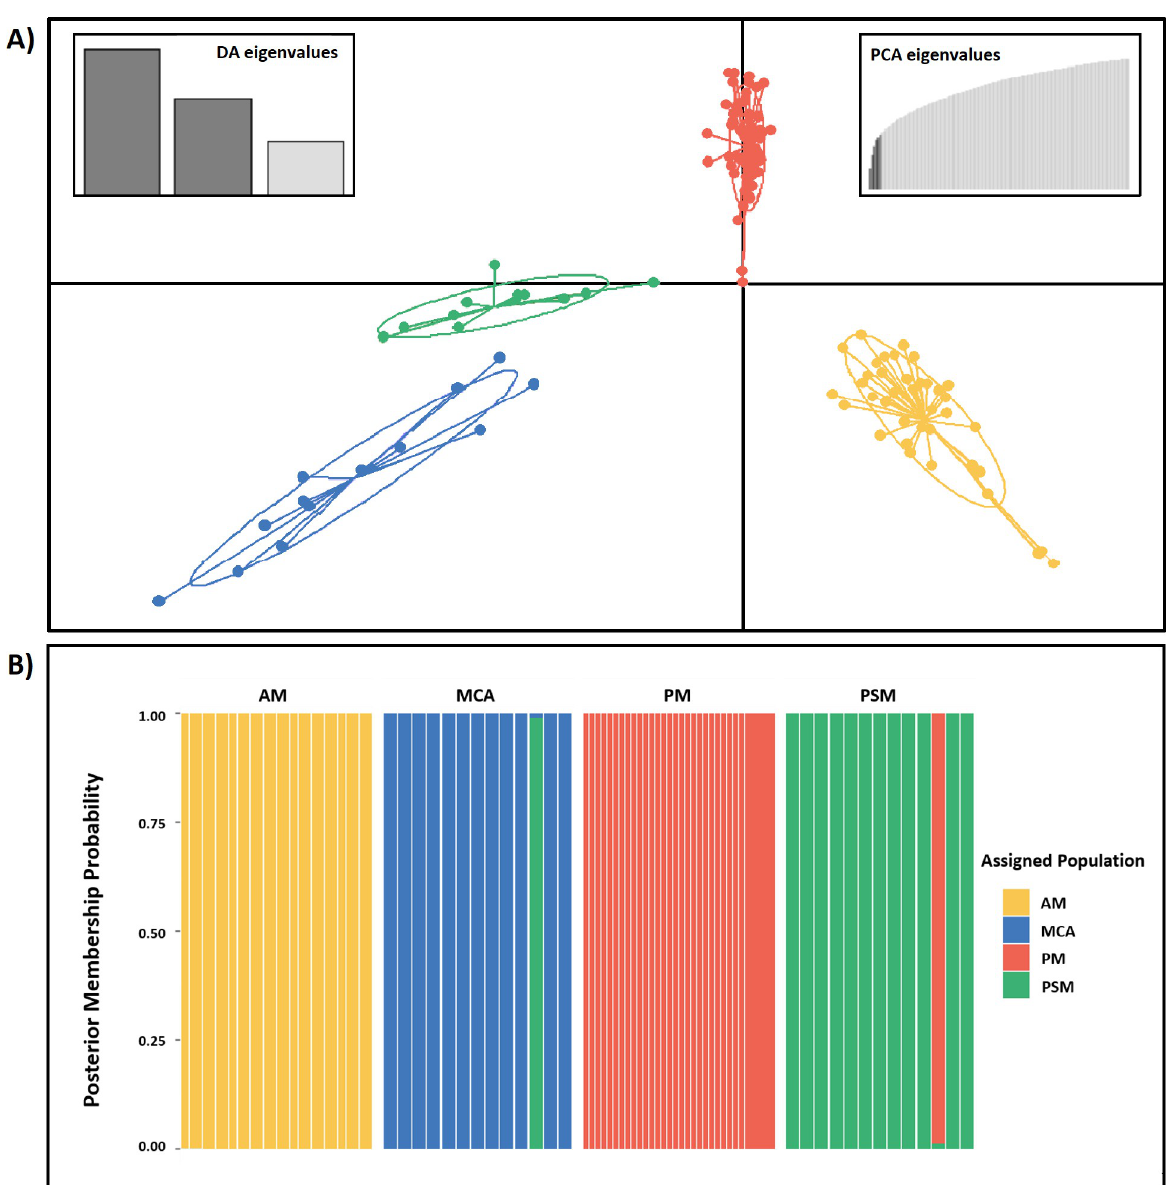
Fig 5. Discriminant Analysis of Principle Components (DAPC) and composite stacked bar plot. A) Discriminant Analysis of Principal Components (DAPC) of populations. Ellipses represent 95% confidence intervals. B) Composite Stacked Bar Plot of all individuals from the ingroup dataset. In panels A and B, inferred genetic clusters of individuals were correlated with our phylogenetic results (Figs 2 and 4) and assigned colors of the corresponding clade, as follows: PM cluster, red; AM cluster, orange; PSM cluster, green; MCA cluster,